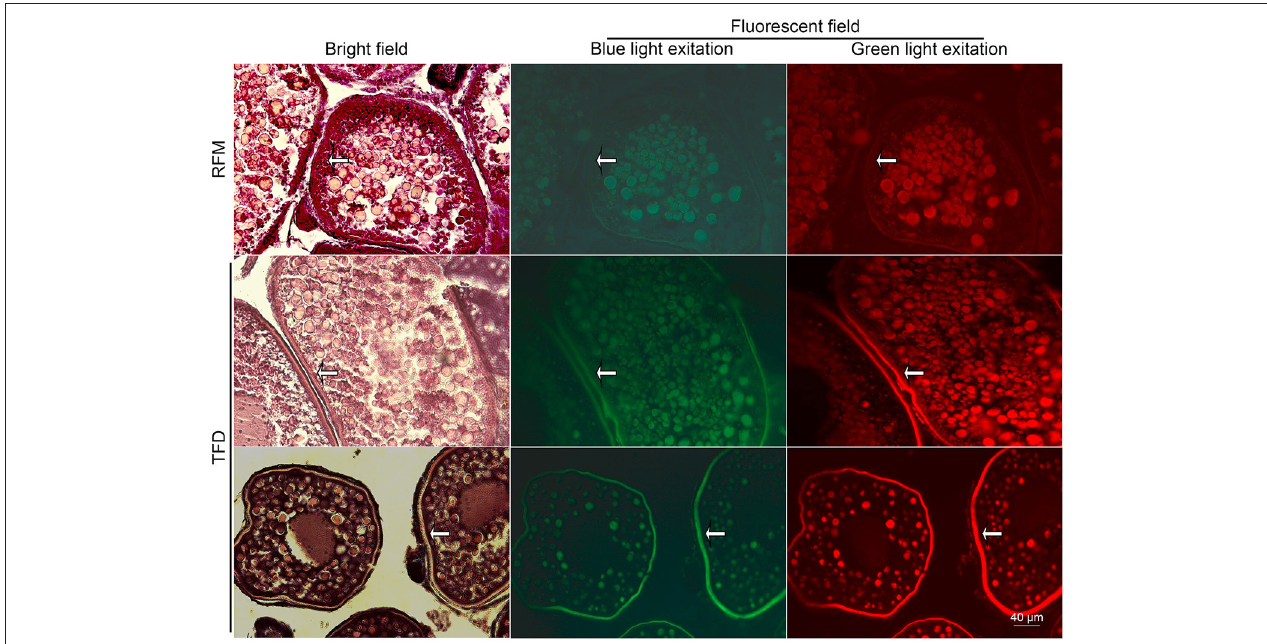
FIGURE 3 | Autofluorescence of the ovarian HE stained sections in bright and fluorescent fields. White arrows represent the strengthen autofluorescence patterns in the follicle walls. Scale bars, 40 µ m.